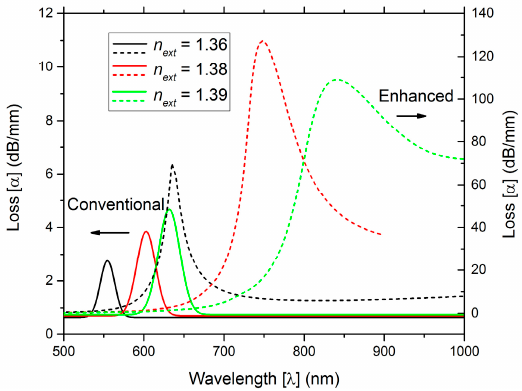
Figure 2. Loss vs wavelength for three external refractive indices.